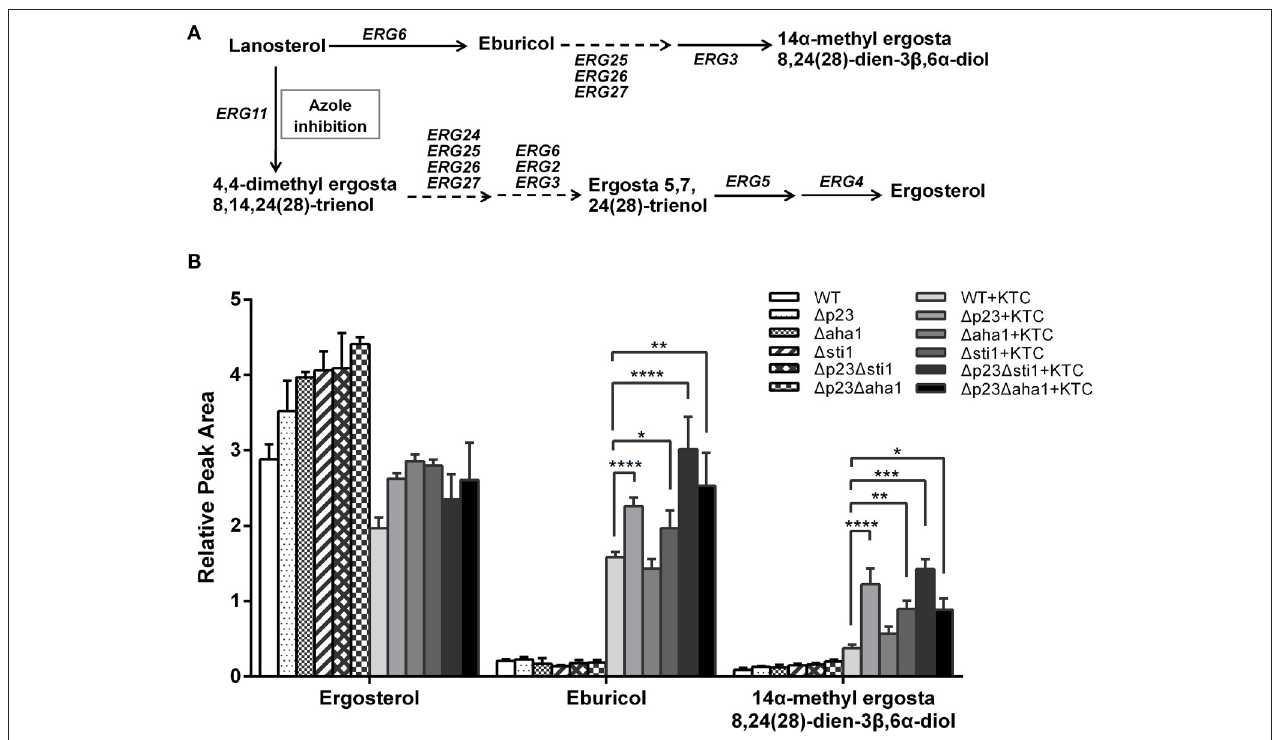
FIGURE 5 | Schematic representations of the ergosterol biosynthetic pathway (A) and quantification of sterol accumulations (B) in wild-type N. crassa and the knockout mutants. Strains were grown in liquid Vogel’s medium at 28 ◦ C with shaking at 180 rpm for 12 h. Then ketoconazole (KTC) was added to the medium to reach 2.5 mg/L. After 24 h incubation, ergosterol, eburicol, and 14 α -methyl-3,6-diol were analyzed by LC-MS with fluconazole as a standard reference. Values shown are the means of three independent replicates. Standard deviations are indicated by error bars. Differences between the mutants and the WT were statistically analyzed by analysis of variance. Values with P < 0.0001, 0.0001 < P < 0.001, 0.001 < P < 0.01, and 0.01 < P < 0.05 are marked with ****, ***, **, and *, respectively.